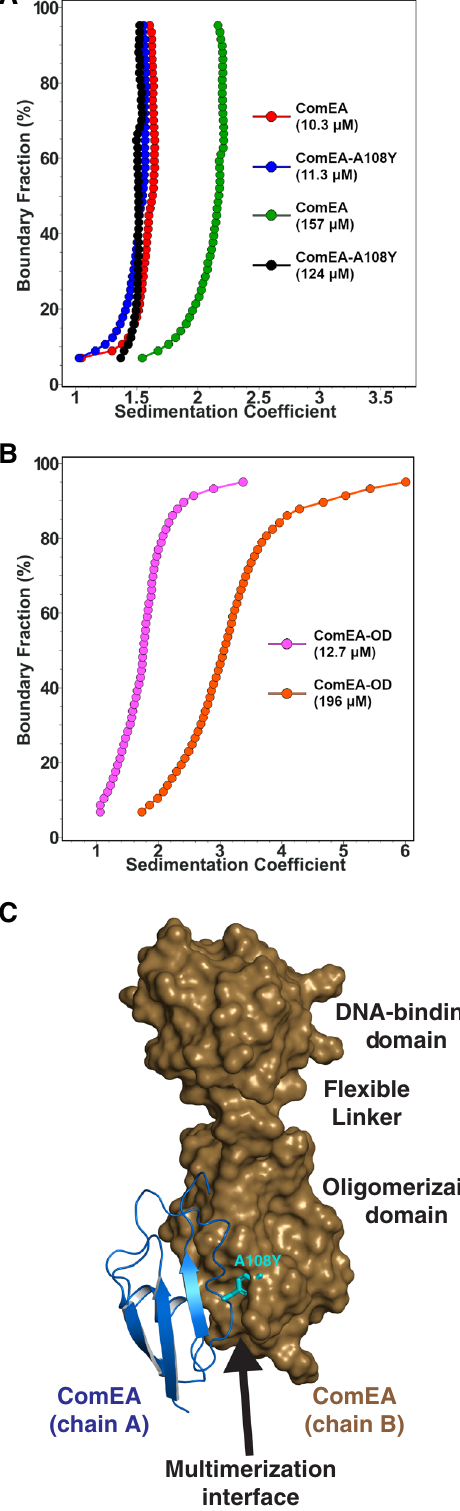
Fig.4|AUCanalysisofComEA,ComEA-A108Y,andtheComEAoligomerization domain. A Integral sedimentation coef fi cient distribution overlays comparing the dimerization potential of ComEA Gs at 10.3 μ M (red) and 157 μ M (green) and ComEA Gs -A108Y at 11.3 μ M (blue) and 124 μ M (black). Only ComEA Gs dimerizes at higher concentration, while ComEA Gs -A108Y remains monomeric. B Integral sedi- mentation coef fi cient distribution overlays of the ComEA Gs OD at 12.7 μ M (magenta)and196 μ M(orange),showingreversibleself-association. C Structureof ComEA Gs with chain A depicted as a cartoon and chain B depicted as a surface. ComEA Gs chain A Ala108 was mutated to Tyr and is depicted as magenta